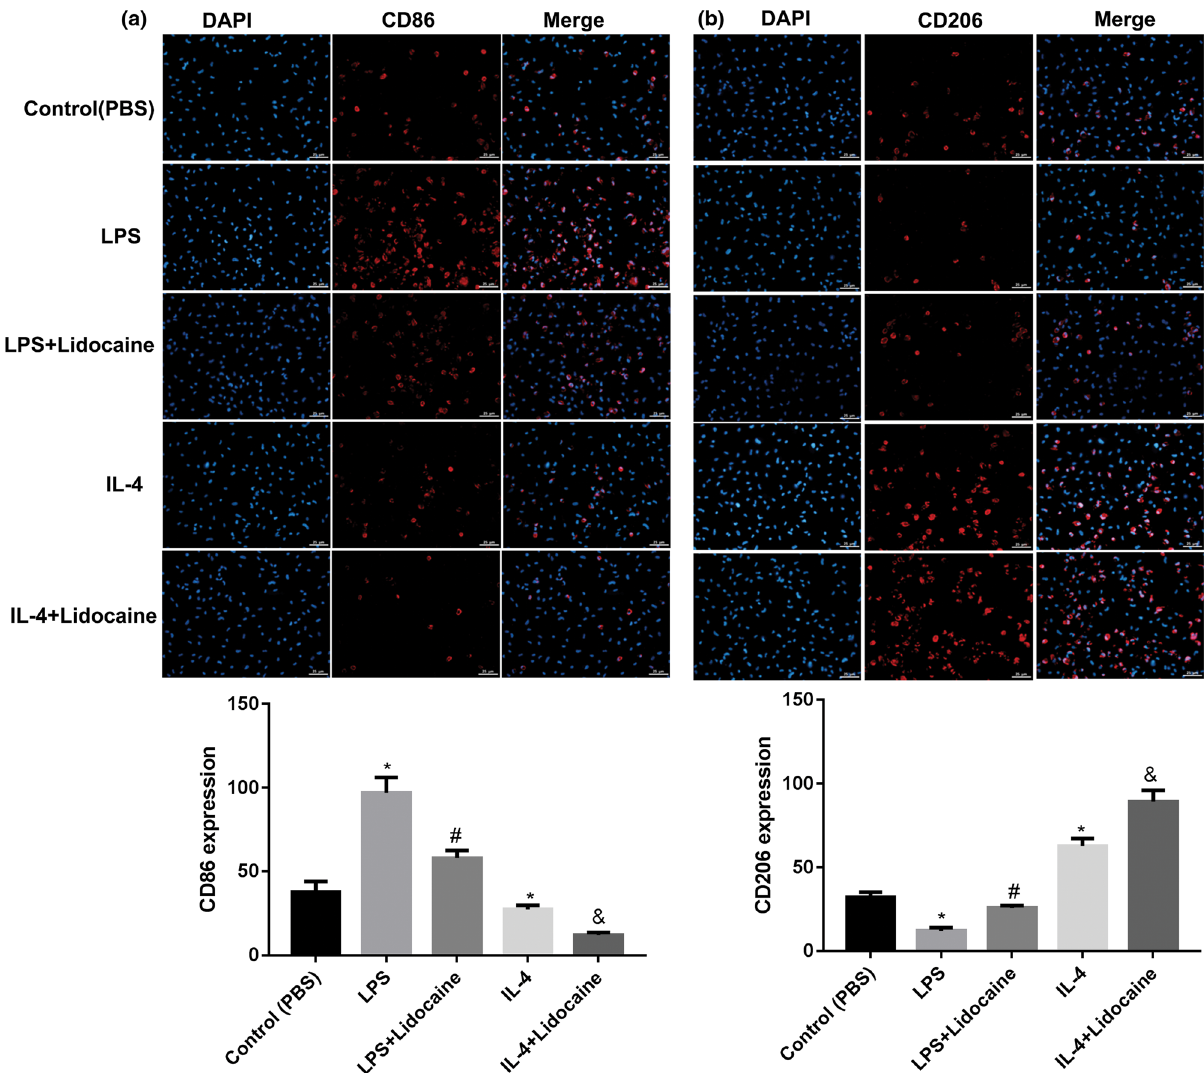
Figure 4: Lidocaine regulates M1/M2 microglia polarization in vitro. The expression levels of M1 and M2 cell markers ( a ) CD86 and ( b ) CD206, in LPS - or IL - 4 - treated HAPI microglia were detected using immuno fl uorescence and quali fi ed. Data are expressed as mean ± SD and were analyzed using one - way ANOVA with Tukey ’ s post hoc test. * p < 0.05 versus Control group; # p < 0.05 versus LPS group; and & p < 0.05 versus IL - 4 group, three independent